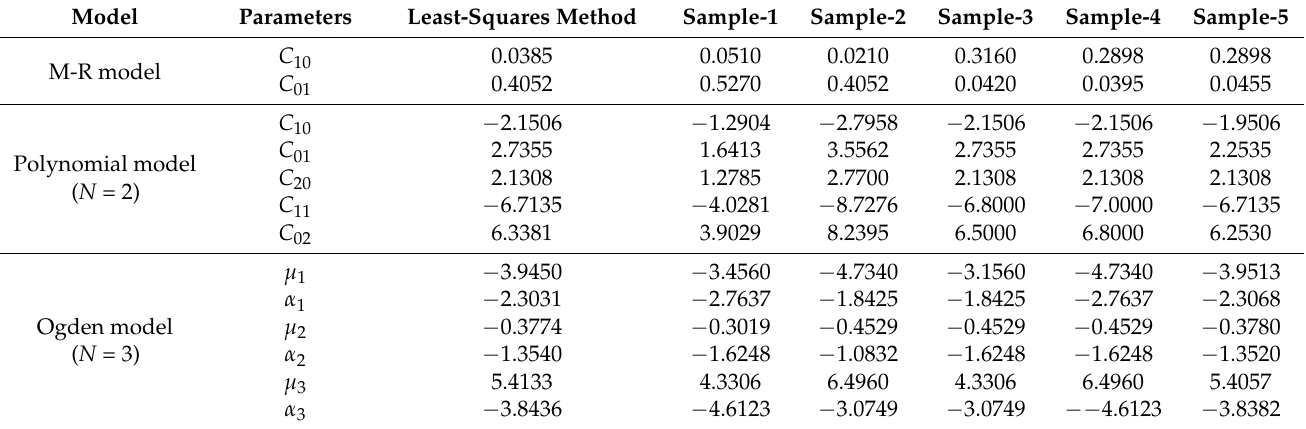
Table 1. User-defined model parameters.